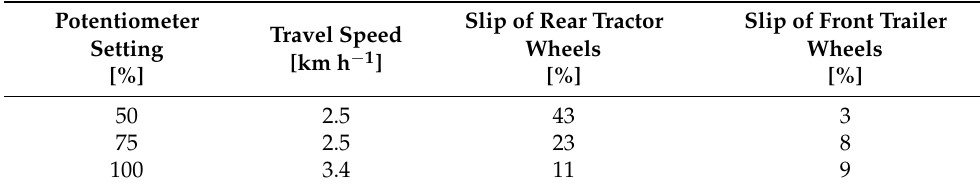
Table 3. Values of the wheel slip in the tractor-trailer unit travelling on an unpaved surface in relation to the setting of the potentiometer controlling the trailer hybrid